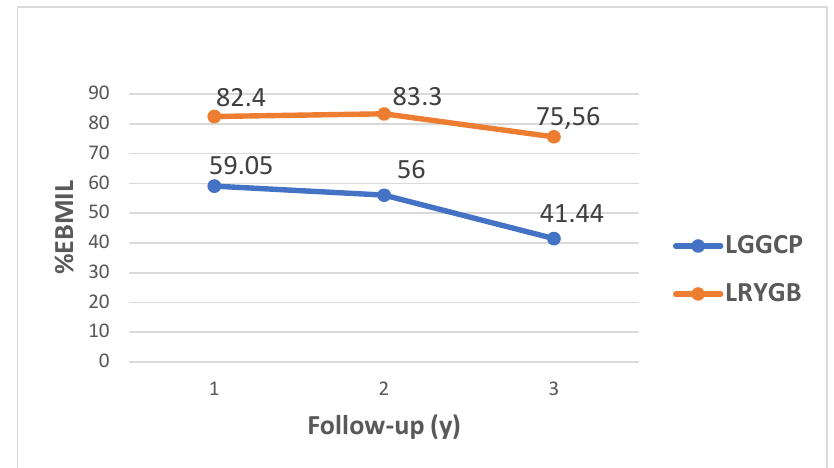
Figure 2. Mean %EBMIL after LGGCP and LRYGB at 1 year, 2 year and 3 year. Thirty-six patients in the LGGCP group and thirty-nine in the LRYGB group had hypertension, and the data about thirty-two (88.9%) and thirty-six (94.7%) patients, re- spectively, were available 3 year after surgery. Nineteen (59.4%) in the LGGCP group and twenty-five (69.4%) in the LRYGB group achieved remission (Table 3). Preoperatively, six patients in the LGGCP group and twelve patients in the LRYGB group had T2DM, and the data about five (83.3%) and eleven (91.7%) patients, respectively, were available 3 year after surgery. Complete remission was observed in three (60%) patients in the LGGCP group, which were treated with oral antidiabetic medications (OAD) before surgery, and nine (81.8%) patients in the LRYGB group (Table 4). Both techniques had a statistically significant effect on the remission of hypertension and T2DM, but there was no significant difference in the remission of comorbidities between the